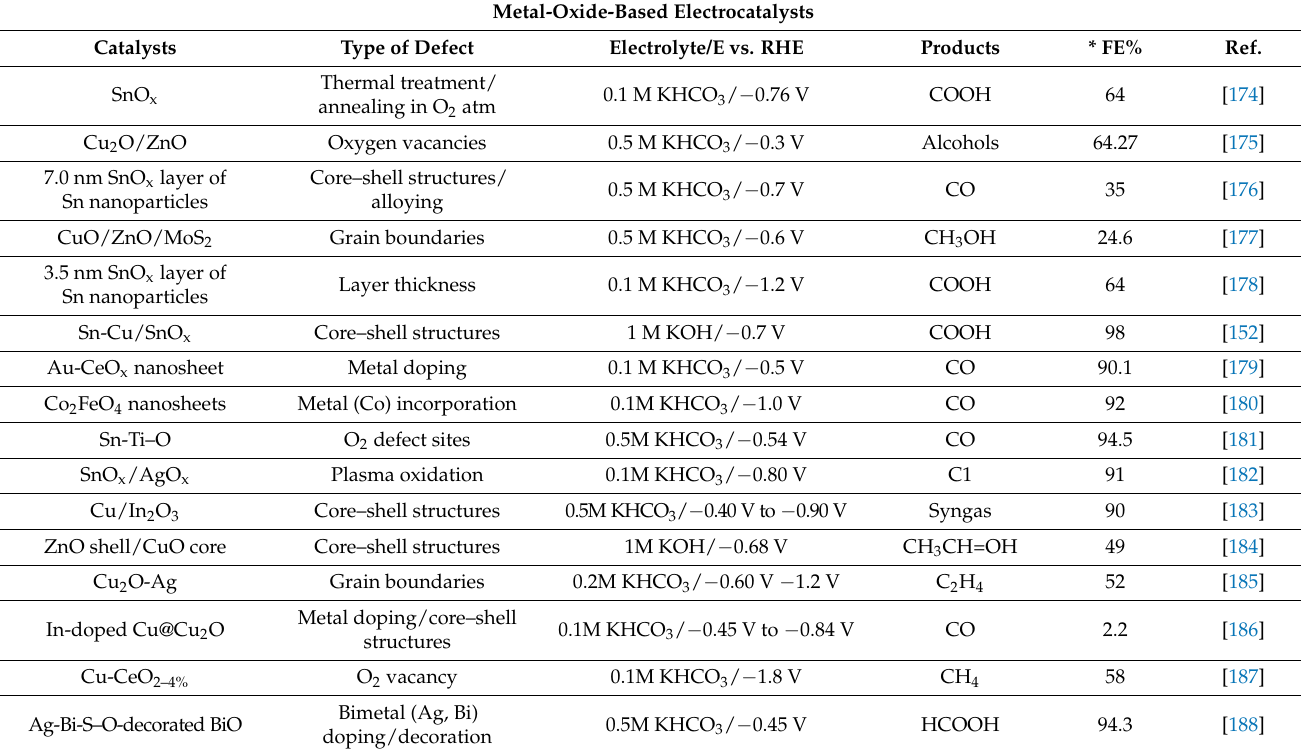
Table 3. Metal-oxide-based electrocatalysts for electrochemical CO 2